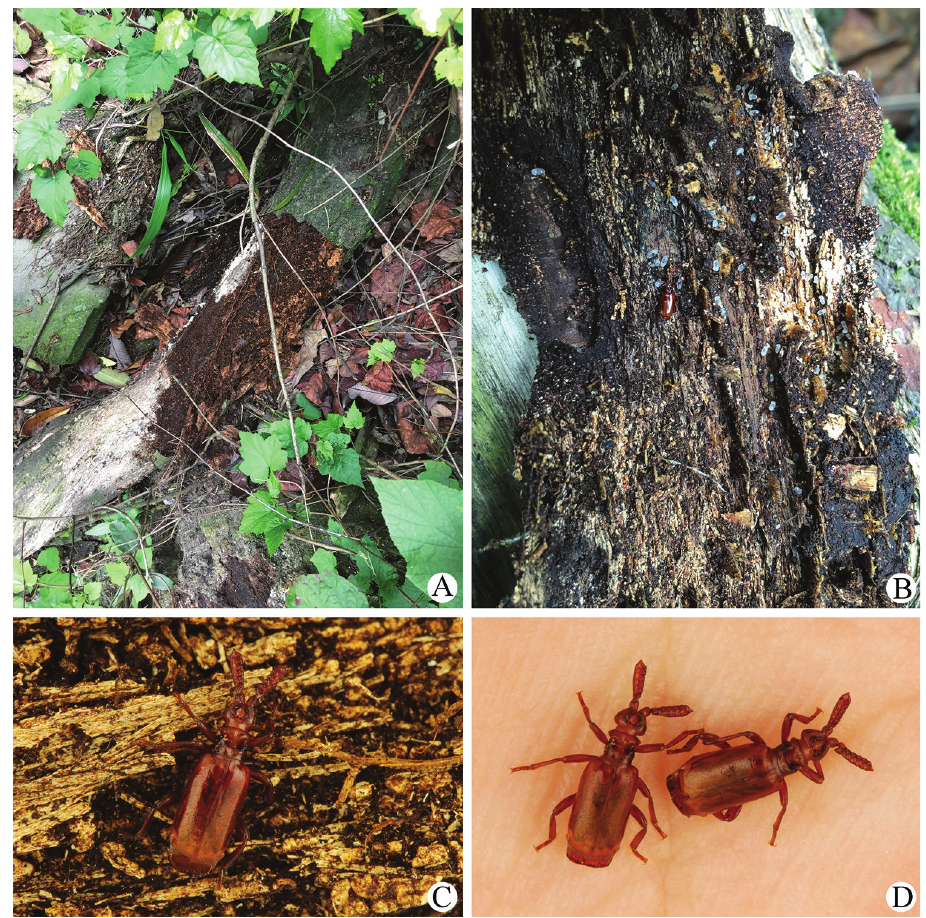
Figure 6. Field observations (Sichuan: Lingyanguanyinshan scenic area) of Paussus ( Scaphipaussus ) zhouchaoi sp. n. (Photoed by Li He) A biotope B the rotten deadwood inhabited by P. ( S. ) zhouchaoi sp. n. and its host ants ( Pheidole sp.) C P. ( S. ) zhouchaoi sp. n. on the rotten deadwood D P. ( S. ) zhouchaoi sp. n. on the palm of the collector Li